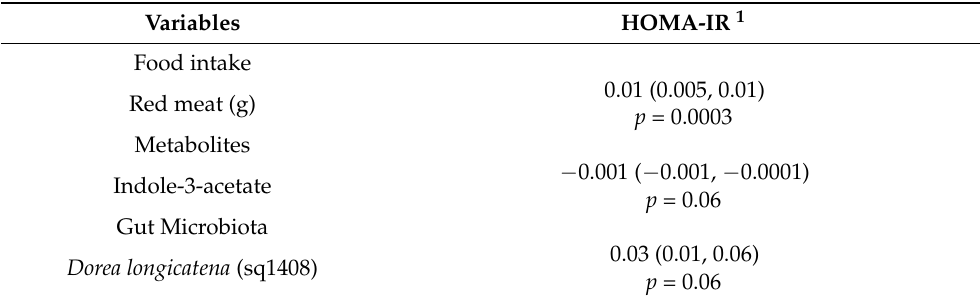
Table 5. Multiple regression model with the effect of variation ( ∆ postoperative—preoperative) of food intake, tryptophan metabolites, and gut microbiota (independent variables) on postoperative HOMA-IR (dependent variable).